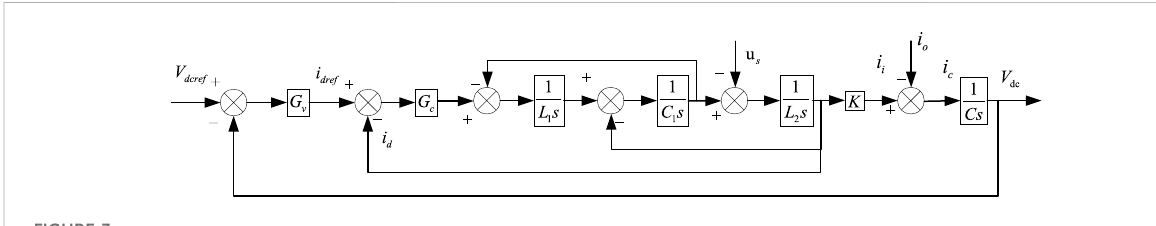
FIGURE 3 Block diagram of the double closed-loop control of the LCL converter.